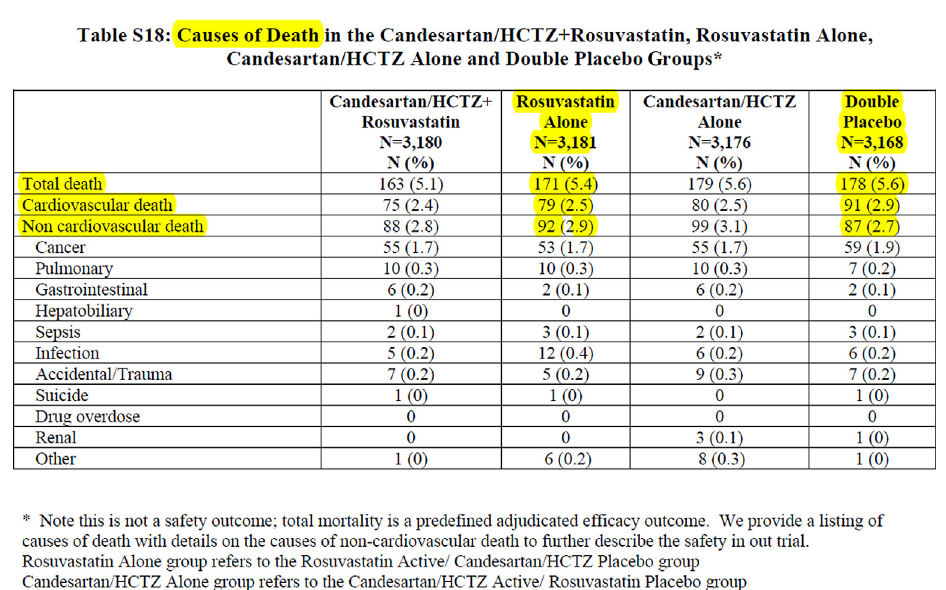
Figure 4. Reproduction of Table S18 in the Supplementary materials provided in the HOPE-3 trial. (Figure reproduced under license from the original